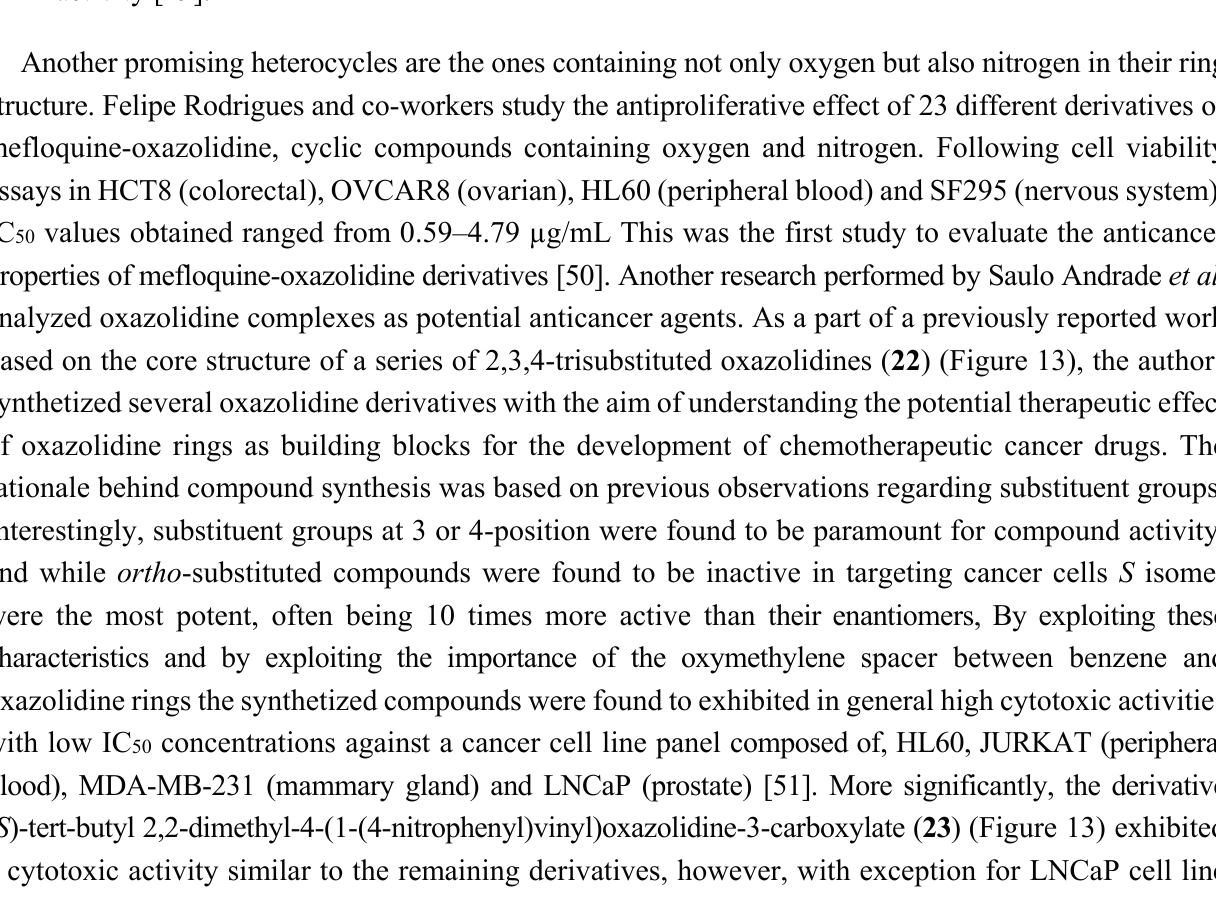
Figure 12. Chemical structure representation of benzofuran core scaffold ( 20 ) and benzofuran derivative, N -(40-hydroxy)phenylamide ( 21 ) with proven anticancer activity against HCT15, ACHN, NUGC-3, MM23, PC-3 and NCI-H23 cell lines through the inhibition of NF- κ B activity